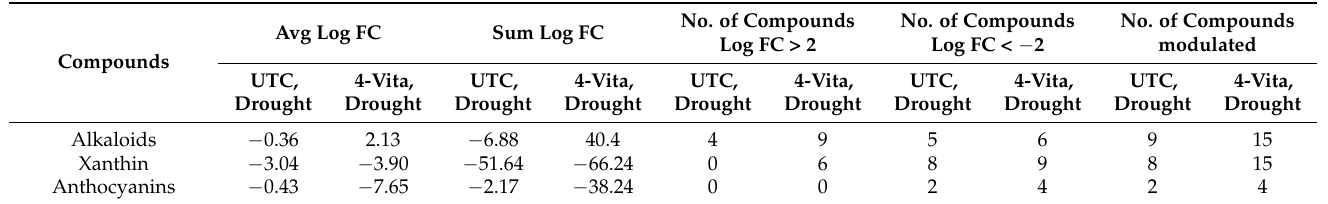
Table 9. Terpenoids compound: alkaloids, xanthin and anthocyanins modulated by 4-Vita in tomato plants under drought stress conditions, compared to untreated control (UTC).